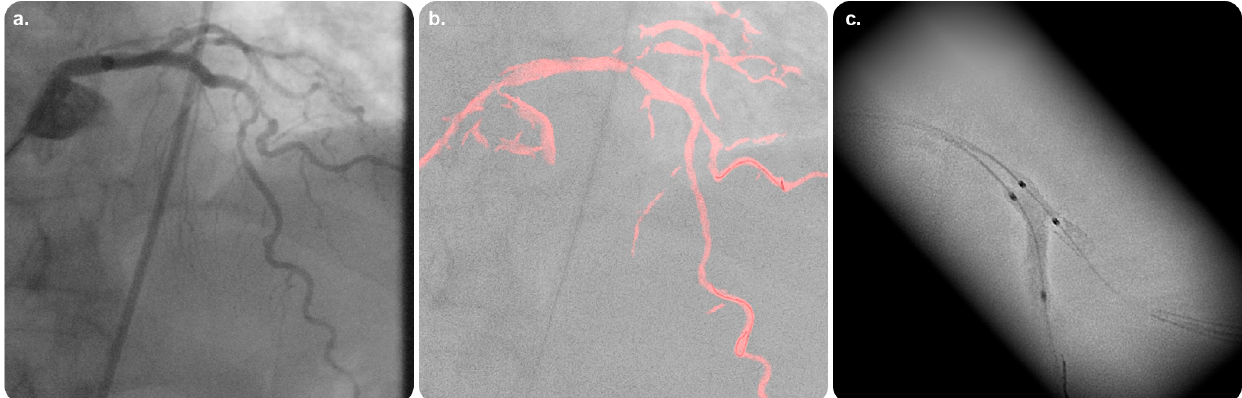
Figure 5. StentBoost Live software and its role in the delivery of targeted therapy. ( a ) Standard static road map with contrast media. ( b ) Coronary road map fused with live fluoroscopy image showing both wires exactly superimposed on the coronaries. ( c ) The software algorithm automatically searches for proximal and distal balloon markers and displays an enlarged and enhanced image of the area around them to insure precise balloon-mounted stent deployment. Reprinted from “On the road: First-in-man bifurcation percutaneous coronary intervention with the use of a dynamic coronary road map and StentBoost Live imaging system” by Dannenberg et al. [32] with written approval from the corresponding author and publisher (International Journal of Cardiology; Copyright 2016).